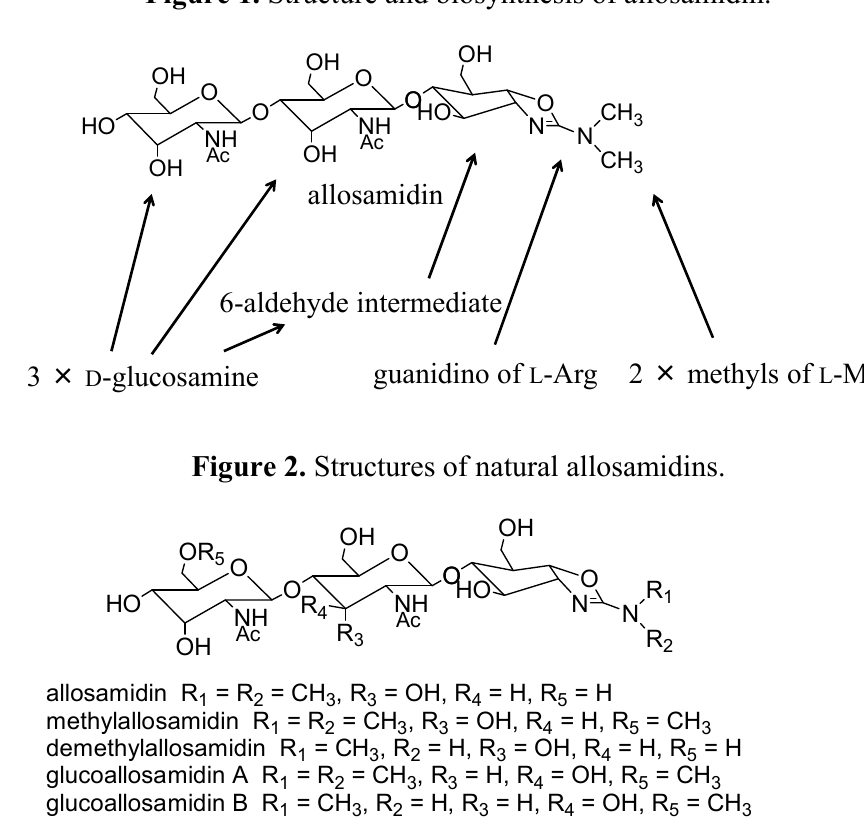
Figure 1. Structure and biosynthesis of allosamidin.